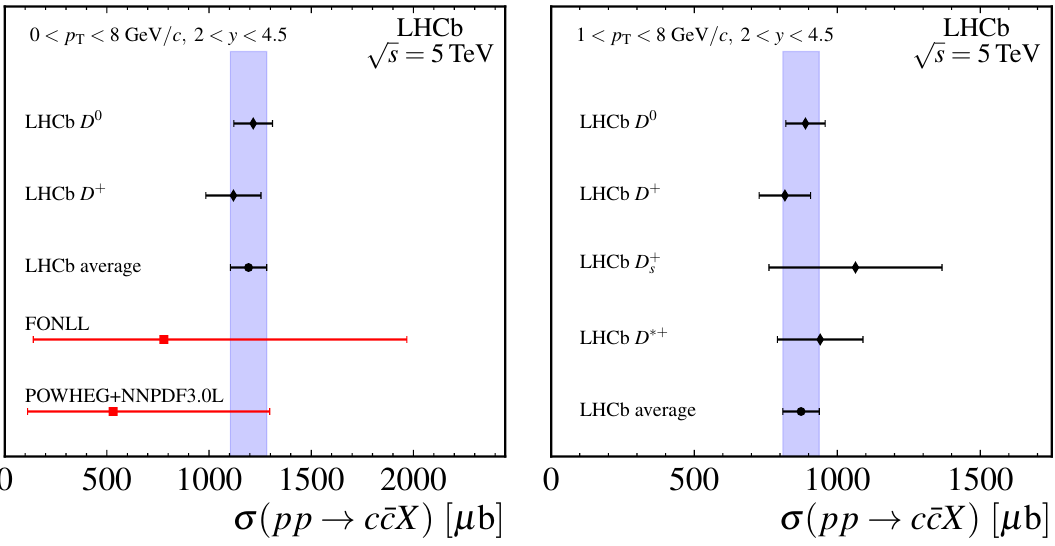
Figure 10. Integrated cc cross-sections (black diamonds), their average (black circle and blue band) and theory predictions (red squares) [1, 2] are shown (left) based on the D 0 and D + for 0 < p T < 8 GeV = c and (right) for measurements based on all four mesons for 1 < p T < 8 GeV = c .